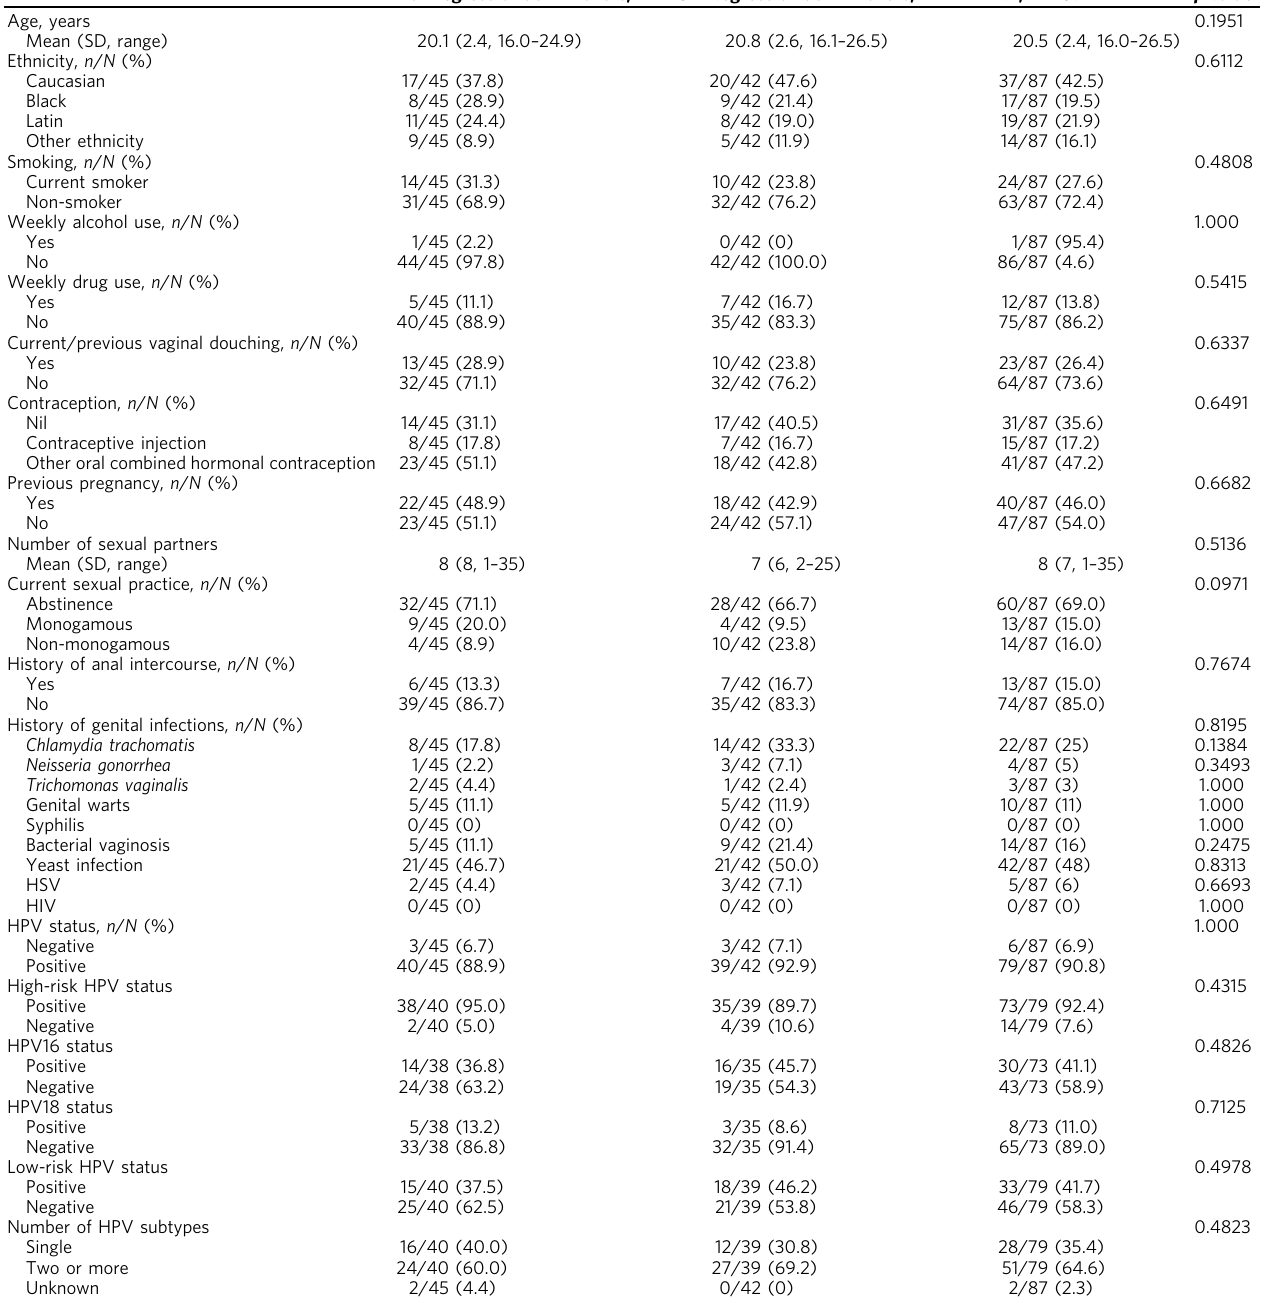
Table 1 Patient characteristics of 87 patients included in study